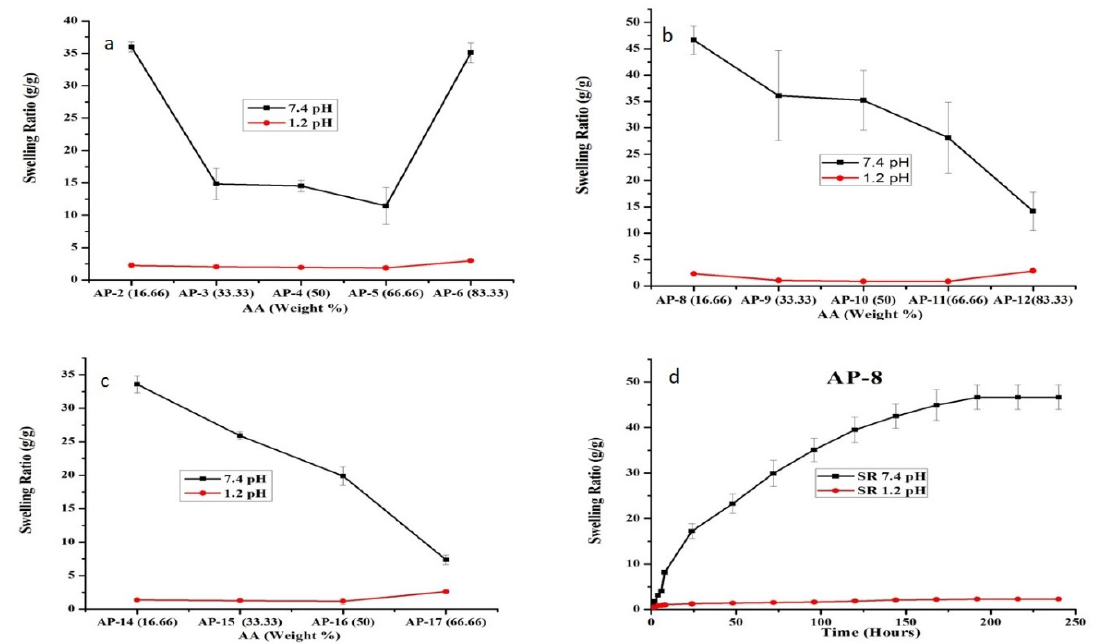
Figure 4. Influence of AA concentration on the equilibrium swelling ratio (g/g) at pH values of 1.2 and 7.4. HP- β -CD concentration remained constant at various concentrations of PVP, i.e., ( a ) 0.3 g, ( b ) 1.33 g, ( c ) 2.66 g. ( d ) Swelling ratio of AP-8 at pH values of 1.2 and 7.4. Here, error bars demonstrate standard deviation ( n = 3).